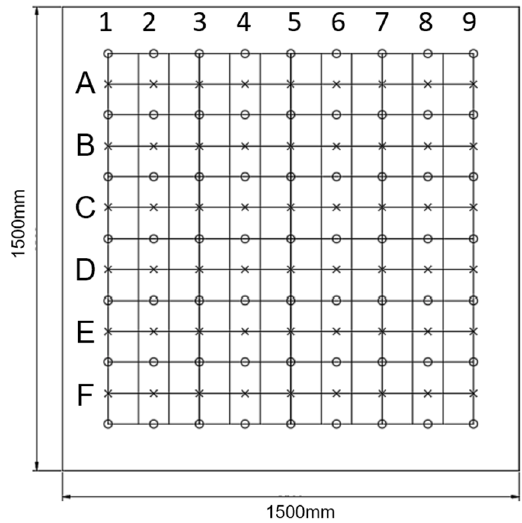
Figure 2. Test grid points on the slab.